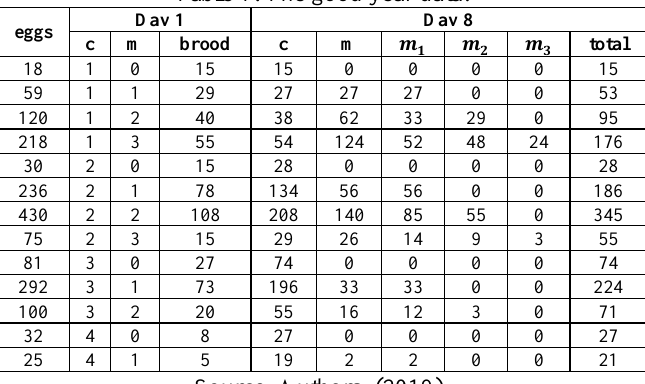
Table 1: The good year